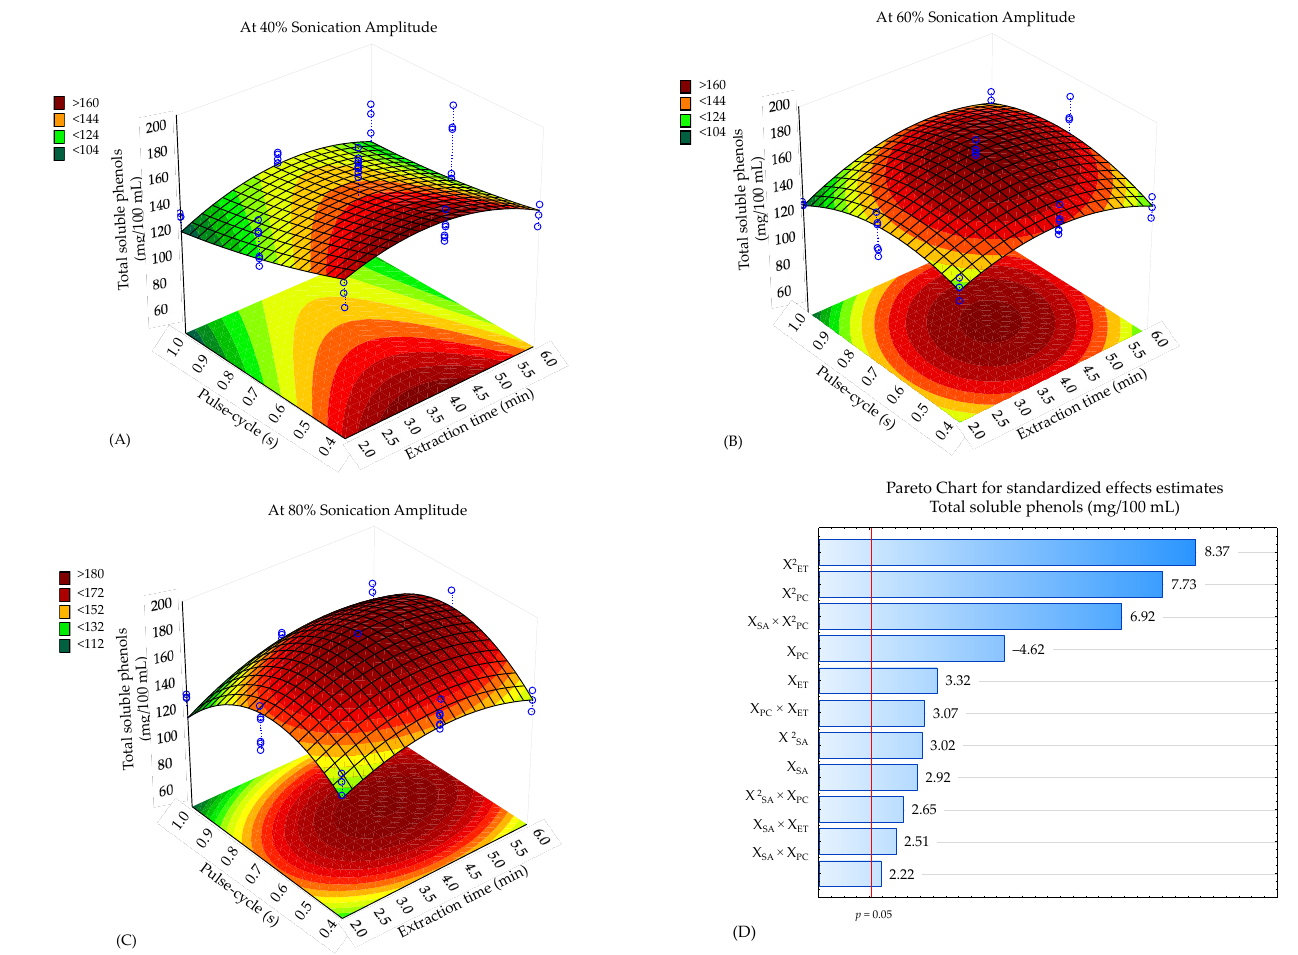
Figure 1. Response surface plots indicating the effect of ultrasound-assisted extraction on total